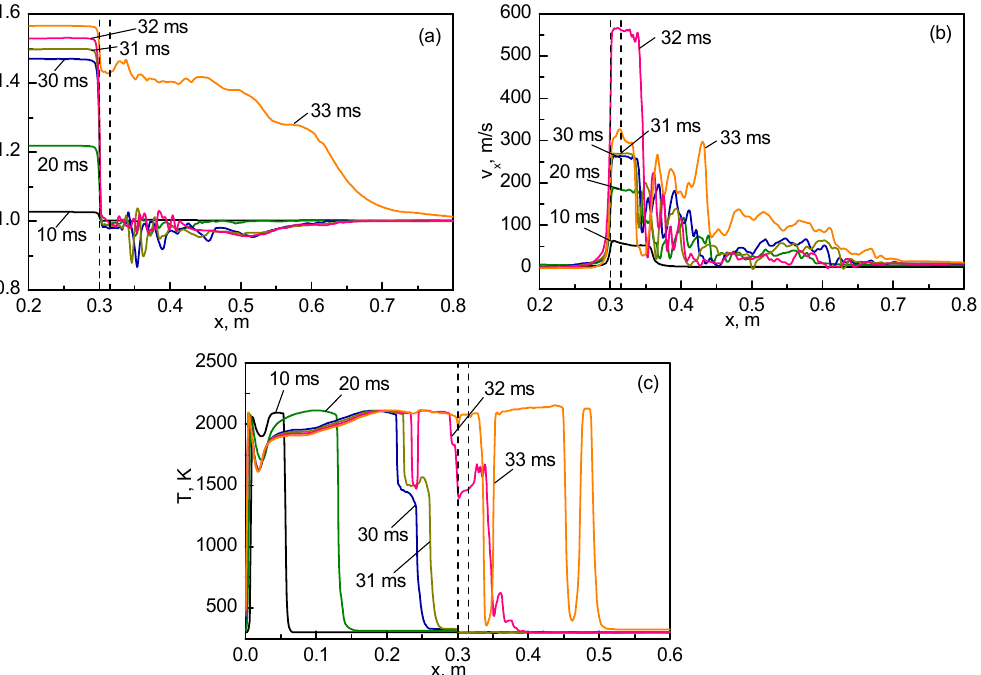
Figure 6. Pressure ( a ), longitudinal velocity ( b ), and temperature ( c ) distributions along the symmetry line at the indicated times (boundaries of the obstacle are shown by vertical dashed lines).